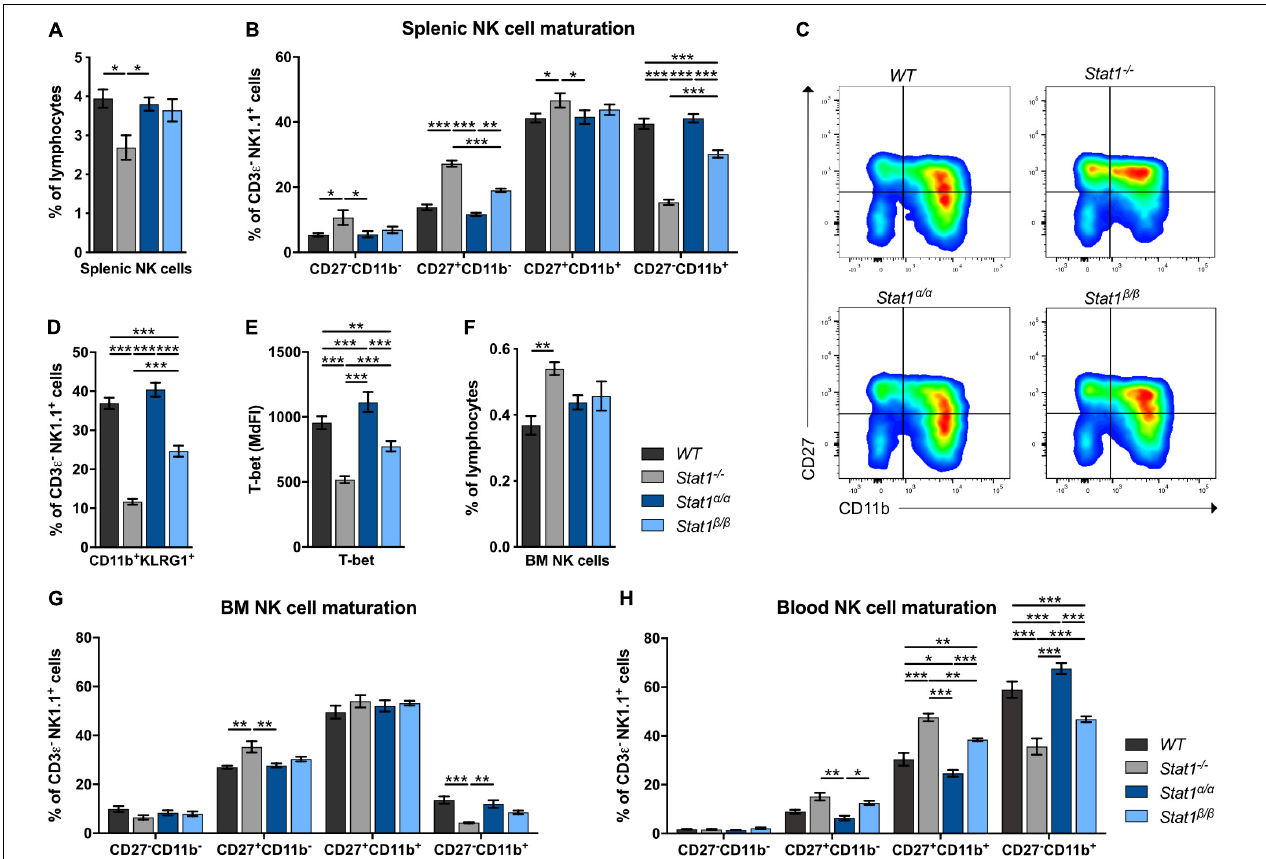
FIGURE 1 | Stat1 β / β , but not Stat1 α / α , mice show impaired NK cell maturation. (A–D) The abundance of NK cells (CD3 ε − NK1.1 + ) (A) , NK cell maturation subsets (CD27 − CD11b − , CD27 + CD11b − , CD27 + CD11b + , and CD27 − CD11b + ) (B,C) and of CD11b + KLRG1 + NK cells (D) were analyzed in spleens of WT , Stat1 − / − , Stat1 α / α , and Stat1 β / β mice. Representative dot blots (C) and mean percentages ± SEM ( n = 7–8) from three experiments (A,B,D) are shown. (E) T-bet expression was determined by intracellular staining and flow cytometry in splenic NK cells (CD3 ε − NK1.1 + ) from WT , Stat1 − / − , Stat1 α / α , and Stat1 β / β mice. Least squares mean of median fluorescence intensities (MdFIs) ± SEM from three experiments ( n = 6–9) are depicted. (F,G) The abundance of NK cells (CD3 ε − NK1.1 + ) in the bone marrow (BM) (F) and NK cell maturation subsets (CD27 − CD11b − , CD27 + CD11b − , CD27 + CD11b + , and CD27 − CD11b + ) in the bone marrow (BM) (G) and the blood (H) from WT , Stat1 − / − , Stat1 α / α , and Stat1 β / β mice were analyzed by flow cytometry. Mean percentages ± SEM ( n = 3–6) from two experiments (F–H) are shown. * p < 0.05; ** p < 0.01; *** p <